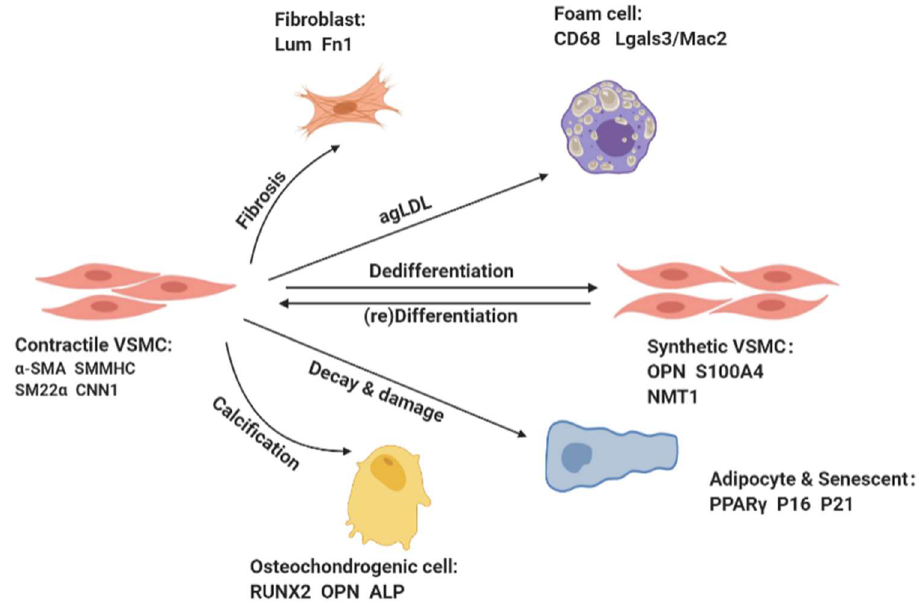
Figure 1. VSMCs can undergo reversible phenotypic switching in response to stimulation by various factors. The differentiated VSMCs in the tunica media are spindle-shaped, expressing abundant contractile proteins (e.g., α-smooth muscle actin (α-SMA), calponin 1 (CNN1), smooth muscle myosin heavy chain (SMMHC), and smooth muscle protein 22-α(SM22α)), and undergo negligible proliferation and migration. The dedifferentiated synthetic VSMCs are epithelioid-shaped, expressing decreased levels of contractile proteins and increased levels of synthetic proteins (e.g., osteopontin (OPN), vimentin, S100 calcium-binding protein A4(S100A4), and N-myristoyltransferase 1 (NMT1)), and they exhibit a high proliferation and migration capacity and synthesize massive amounts of extracellular matrix (ECM). VSMCs can also acquire the characteristics of other cell types, such as osteoblasts, fibroblasts, and foam cells.